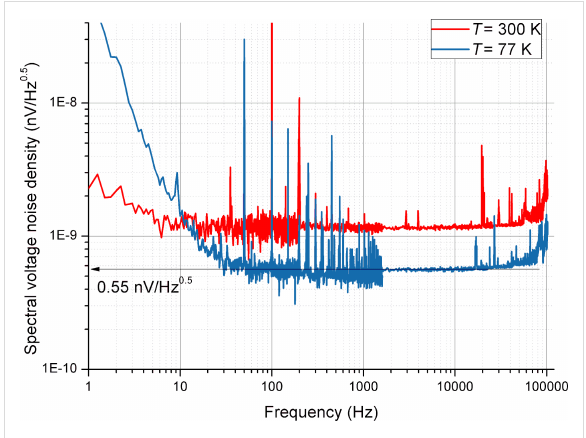
The noise parameters of the amplifiers were measured using a standard measurement procedure. Both inputs of the amplifier were shorted to the ground and the total voltage noise spectral density was measured. The self voltage noise of the SA was previously characterized and it did not exceed 12 nV/ . The measured total noise was defined only by the amplifiers since